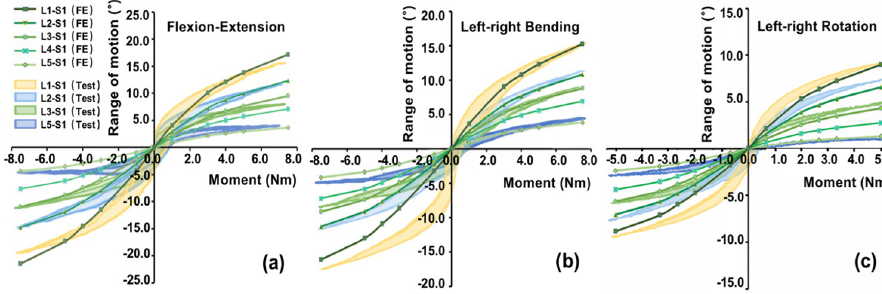
Fig 5. Comparison of the moment-rotation behaviors of the based lumbar-pelvis model with the in vitro experiments under different loads cases.